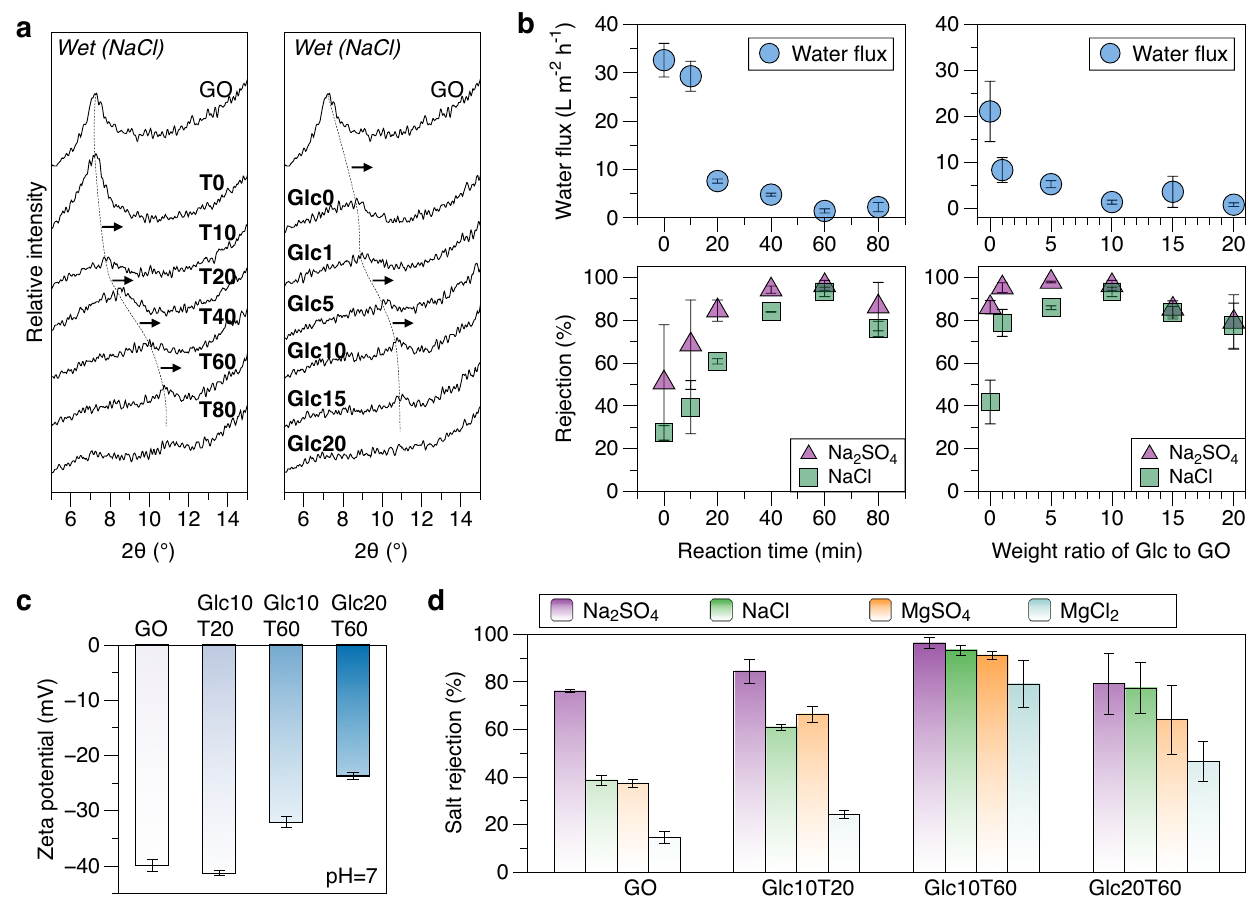
Fig. 4 | Nanochannel deformation in salt solution and reverse osmosis per- formance. a XRD spectra of GO and Glc-rGO samples wetted by 500 ppm NaCl solution (dashed lines and arrows indicate peak shifts); b Separation performance of Glc-rGO membranes; c Surface zeta potentials of GO, Glc10T20, Glc10T60, and